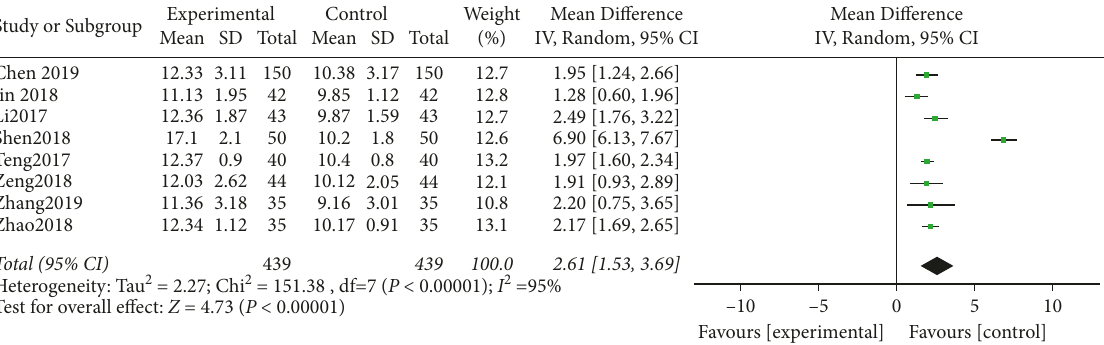
Figure 6: Forest analysis map of comparison of BUT between the two groups after treatment.